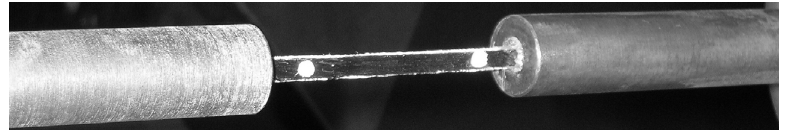
Figure 1: The appearance of highly filled fiberglass specimen for uniaxial tensile test with applied labels for using non-contact extensometer Instron AVE [2]